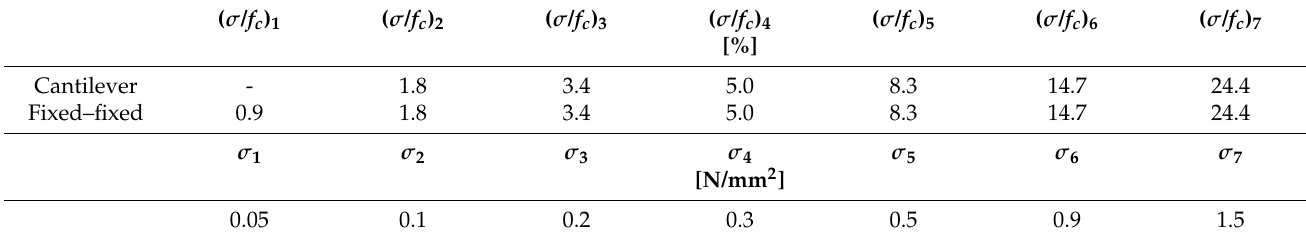
Table 1. Values of the analyzed compression levels.